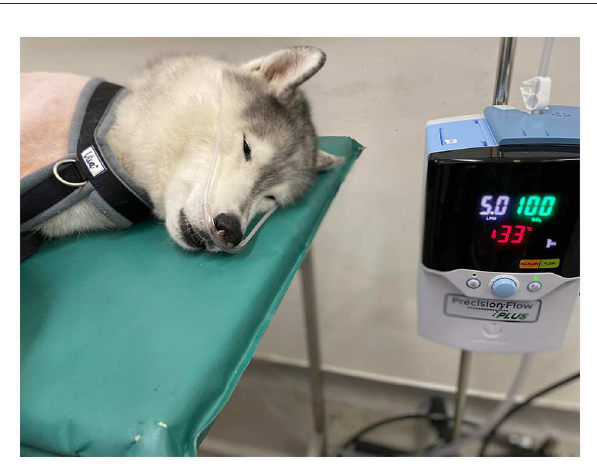
FIGURE1 High-Flow Nasal Oxygen Machine (Precision Flow Hi-VNI, Vapotherm, United States) and positioning of the nasal prongs. This patient was not included in this case series.